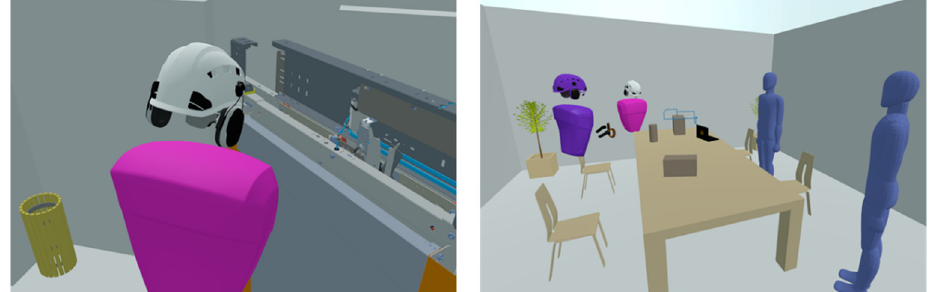
Figure 2. DesignSpace screenshots from user tests in Case 1.